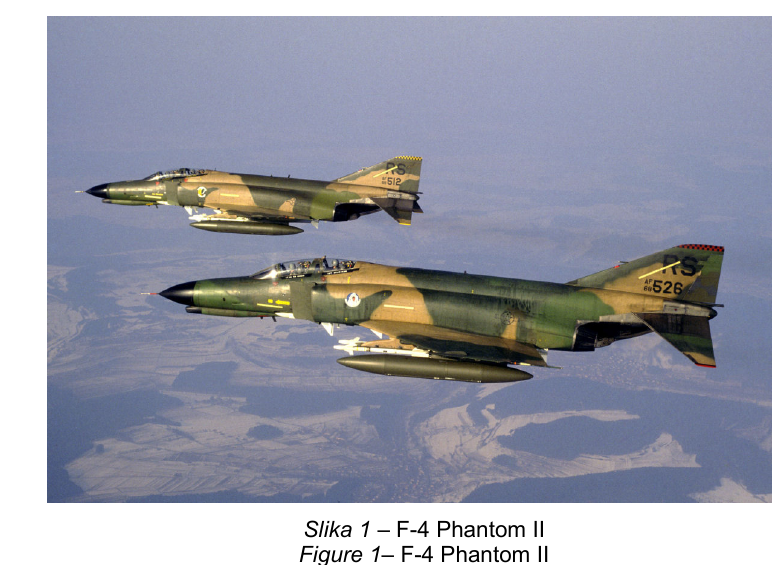
Figure 1 – F-4 Phantom